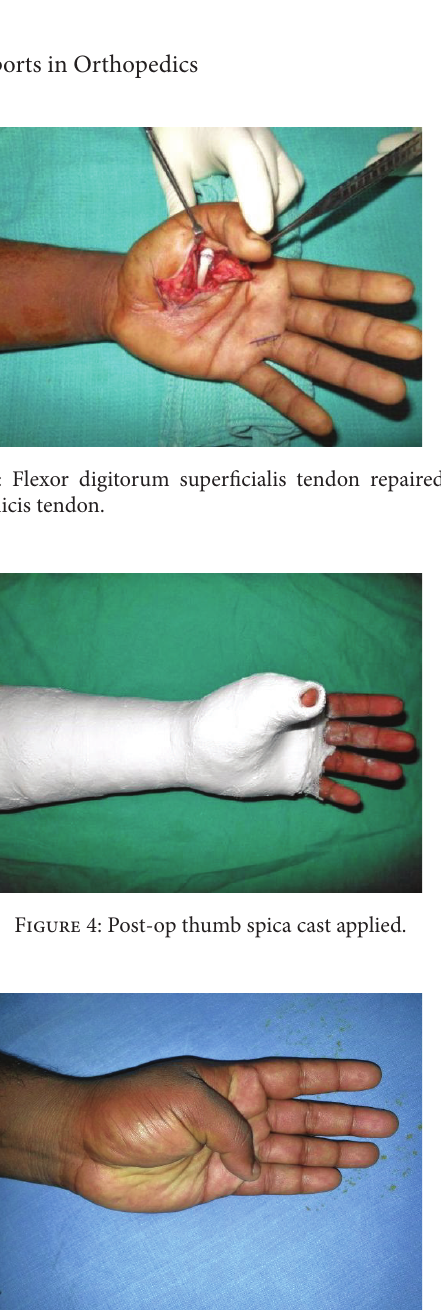
Figure 5: Follow-up showing thumb reaching the little finger basal crease.